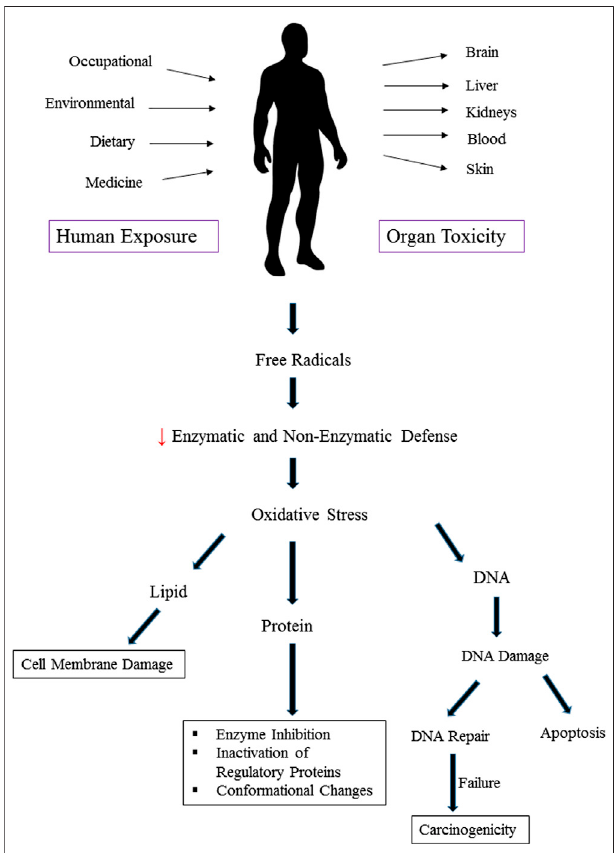
FIGURE 2 | Oxidative stress and organ toxicity following exposure to heavy